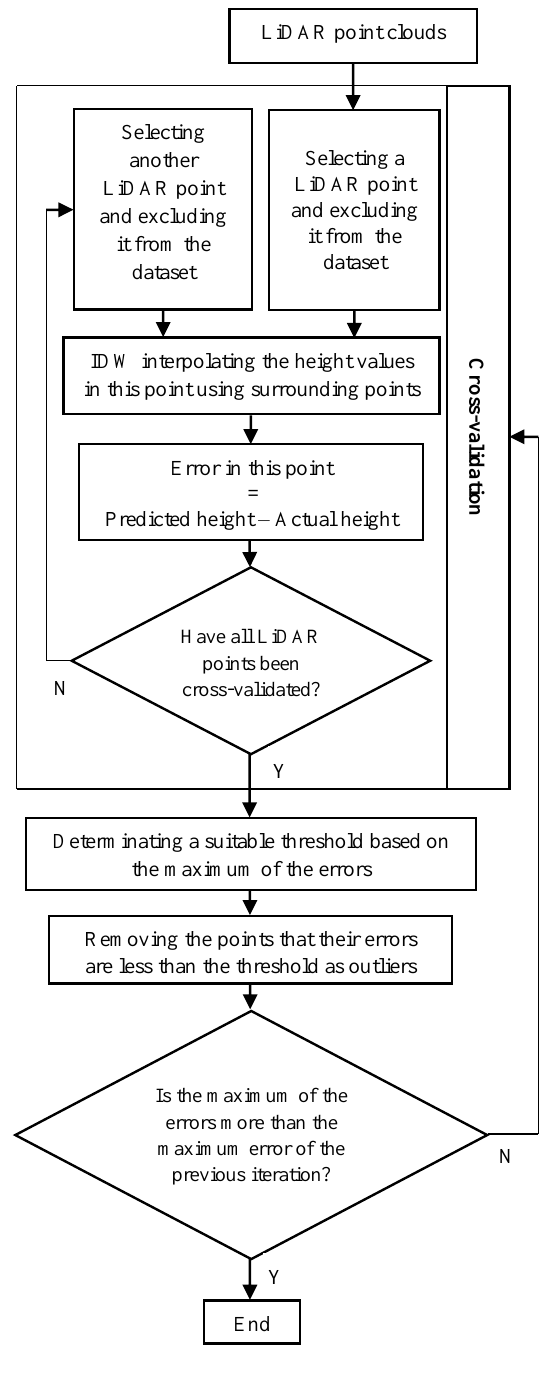
Figure 1. The flowchart of the proposed